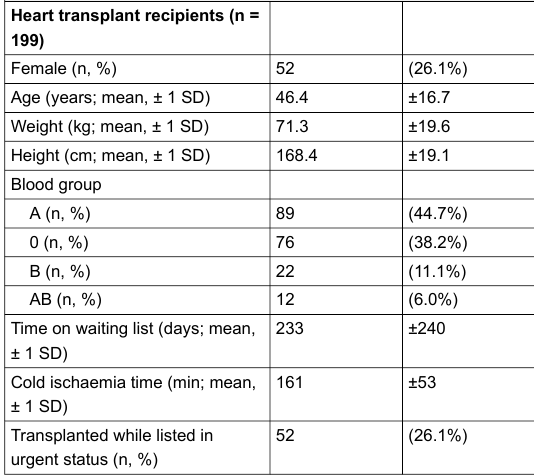
Table 3: Patient characteristics and clinical data of transplant